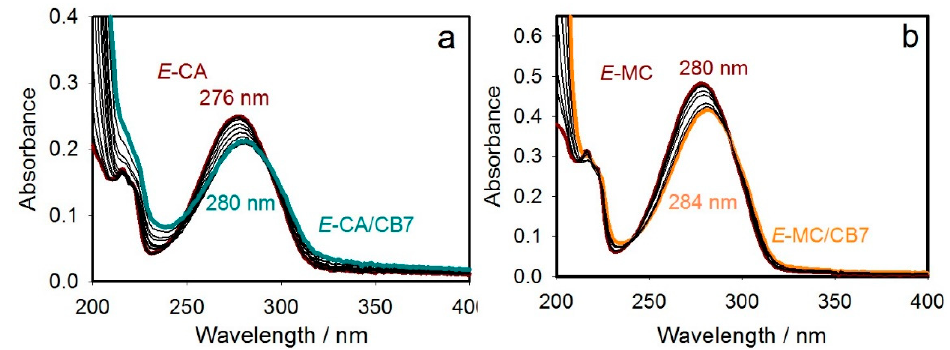
Figure 1. Dependence of the UV − visible absorption spectra of E -CA and E -MC substrates (18 μ M) on the concentration of CB7 (pH 2.5; a , and pH 7.4; b ). For clarity, the initial and final spectra are shown in matching colors with the dominant chemical species. The numbers are the corresponding maxima (in nanometers).